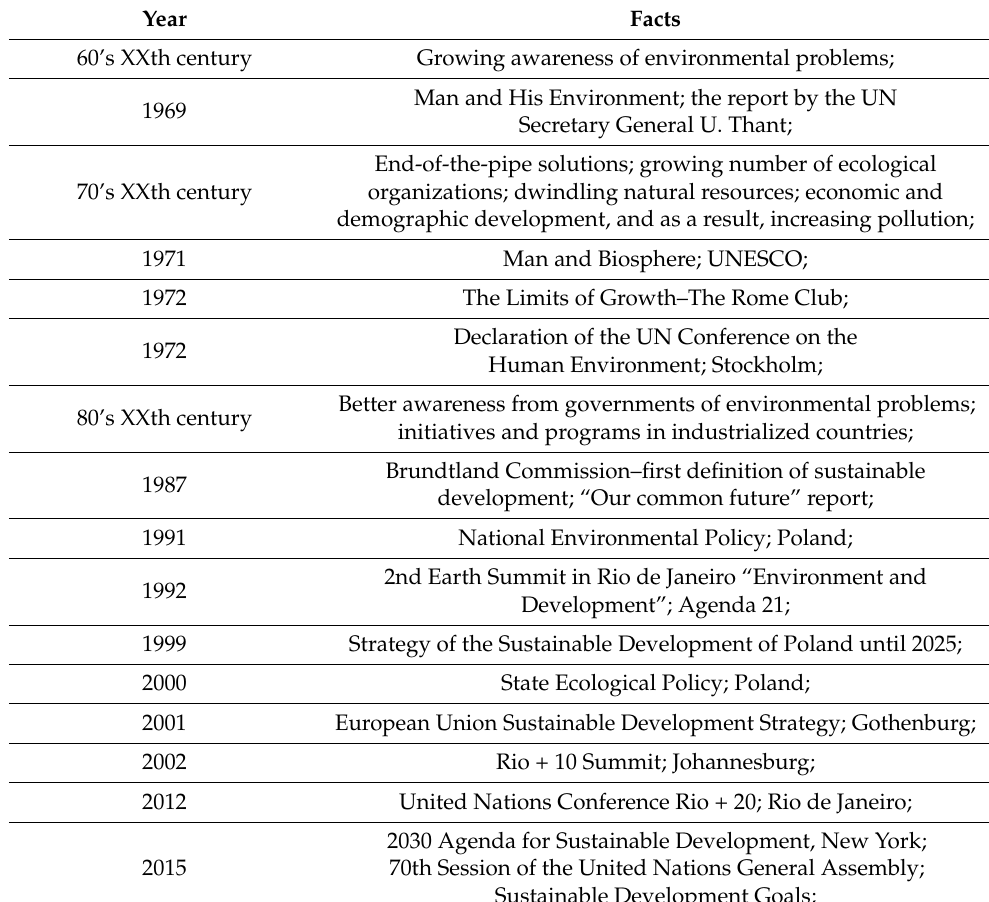
Table 1. The concept of sustainable development from a time